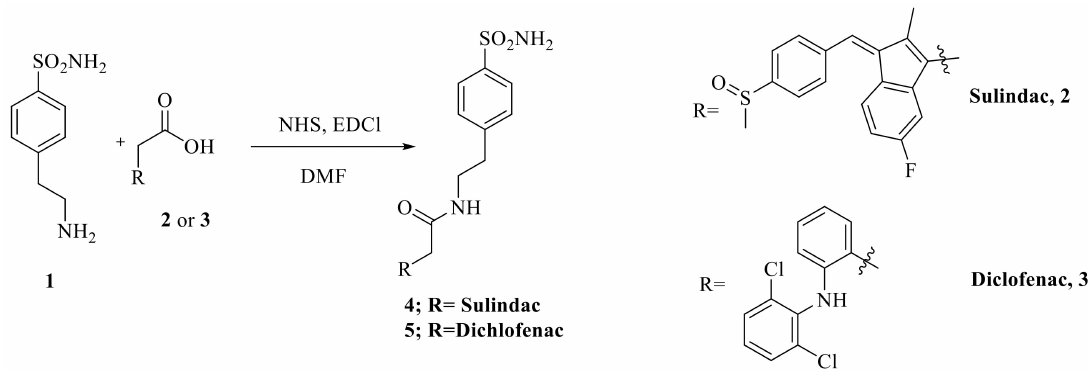
Scheme 1. Synthetic procedure of the nonsteroidal anti-inflammatory drugs and carbonic inhibitors (NSAID-CAI) hybrids herein considered [13].